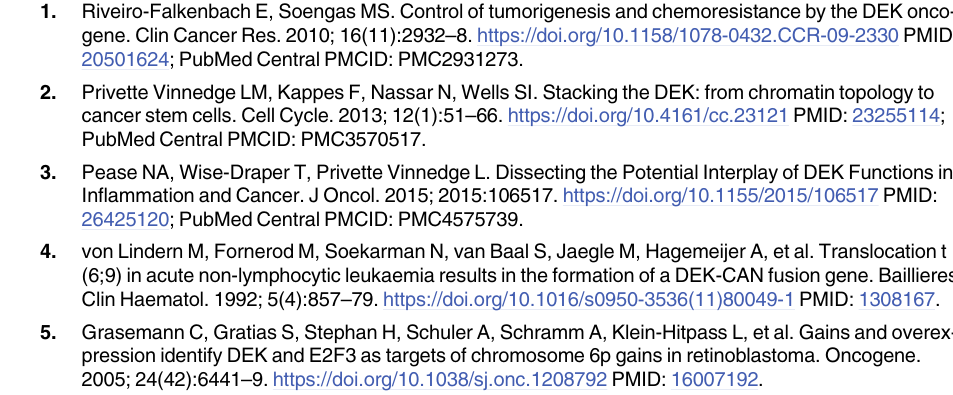
S1 Fig. FACS analysis indicates percentage of GFP + cells after the FACS-sort. (TIF) S2 Fig. FlagDEK1 expression level in shDEK+FlagDEK1 cells. S1 Table. Hazard ratios of DEK1 for disease specific survival. S2 Table. Hazard ratios of DEK2 for disease specific